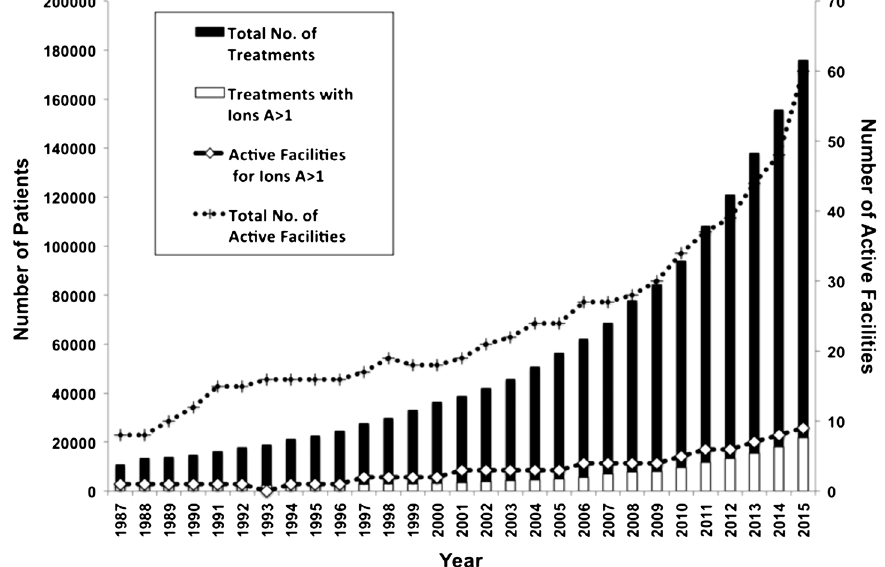
FIG. 1. Number of active ion beam therapy facilities and patients treated. Ions A > 1 designate ions heavier than protons (data from PTCOG statistics